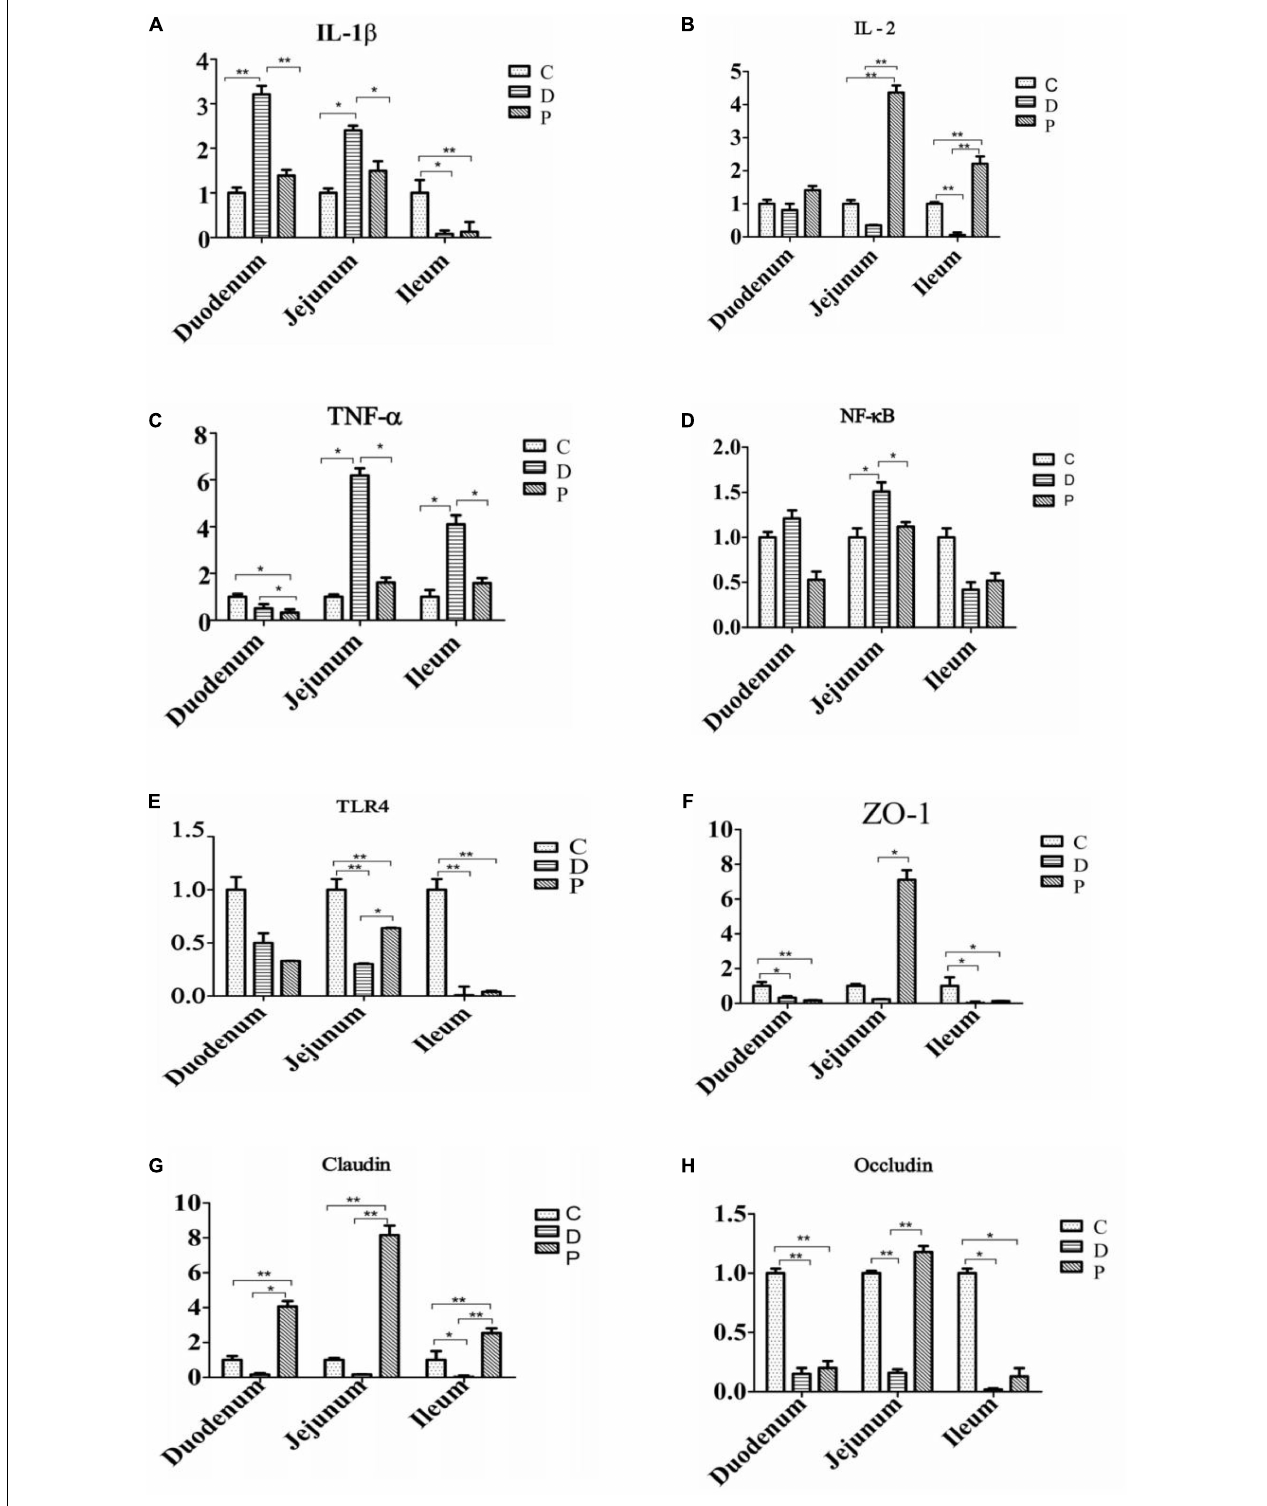
FIGURE 3 | Effect of supplementation with MSP on the relative expression of small intestinal mucosal immune factors and tight junction protein mRNA in neonatal calves infected by E. coli K99 (C, Control group; D, Diarrhea group; P, MSP group; respectively). (A) Interleukin-1 β , IL -1 β . (B) Interleukin-2, IL-2 . (C) Tumor necrosis factor- α , TNF- α . (D) Nuclear factor kappa-B, NF - κ B . (E) Toll-like receptor 4,TLR4. (F) Zonula occludens 1, ZO-1 . (G) Claudin. (H) Occludin. * P < 0.05, ** P < 0.01.